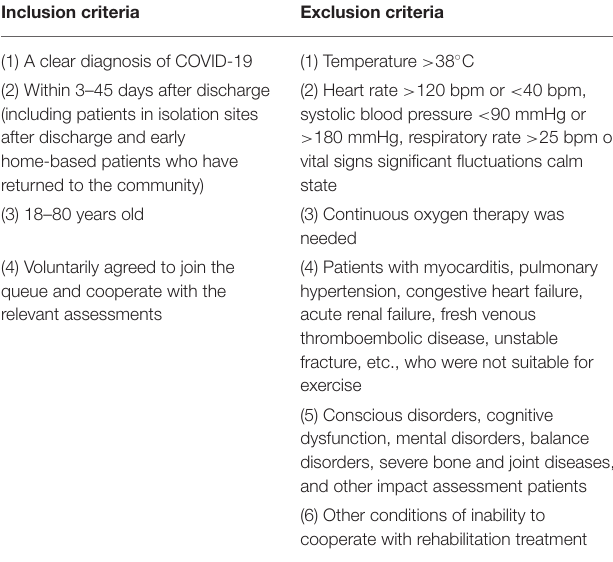
TABLE 1 | Article inclusion and exclusion criteria.